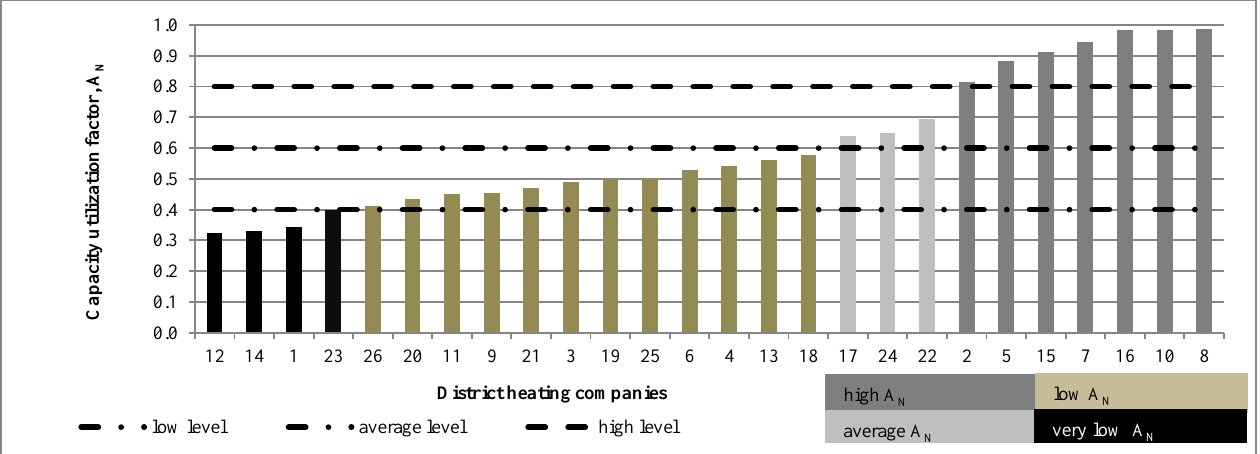
Fig. 4. The capacity utilization factor of large Latvian